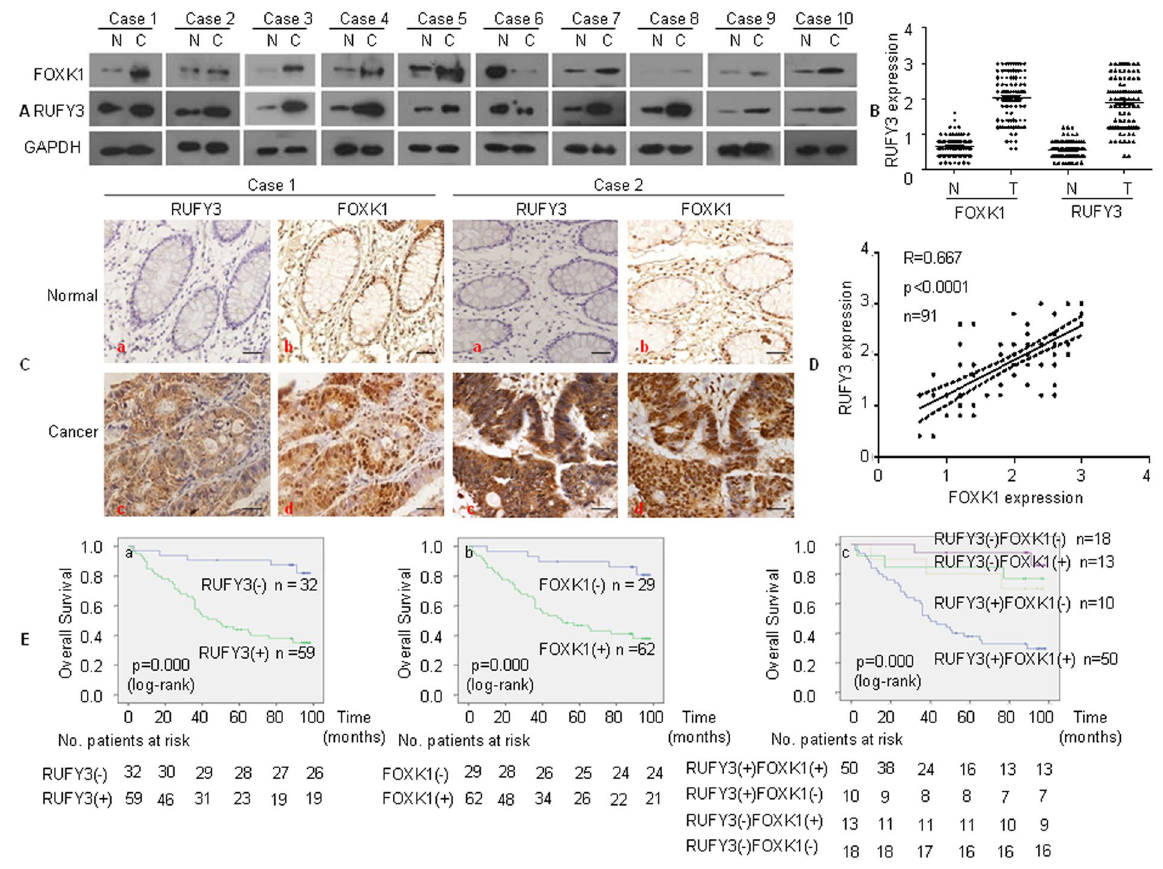
Figure 3. RUFY3 expression positively correlates with FOXK1 expression in human CRC. ( A ) Western blot examination of RUFY3 and FOXK1 protein expression in ten freshly collected CRC biopsies. ( B ) Average scores of the two proteins in normal and cancerous colon tissues. ( C ) RUFY3 (a, c) and FOXK1 (b, d) expression in normal or cancerous colon tissue specimens was detected by immunohistochemistry. Scale bars represent 20 μ m. ( D ) Positive staining for RUFY3 and FOXK1 was quantified, and their correlation was analyzed using Spearman’s correlation method. ( E ) Kaplan-Meier overall survival analysis of CRC patients. Survival analysis was performed according to the expression status of RUFY3 (a), FOXK1 (b), and the combined expression status of RUFY3 and FOXK1 (c), respectively. The full-length blots/gels are presented in Supplementary Figure